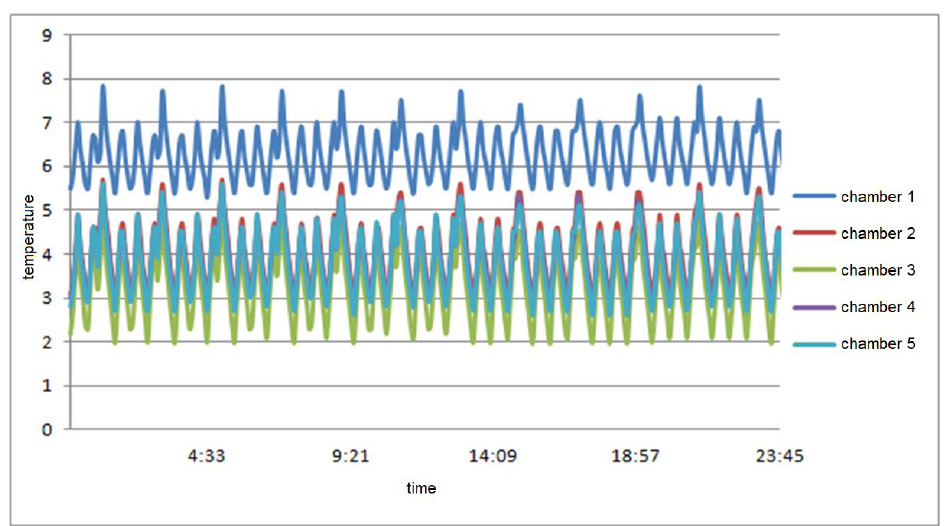
Figure 4. Temperature distribution in the cooling module chambers .